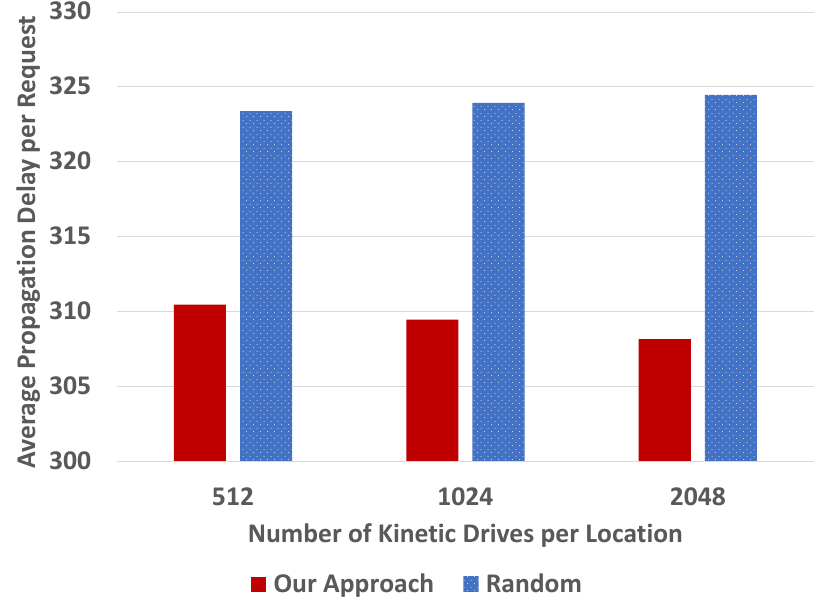
Figure 9. Average propagation delay per request (normalized): 32 regions, 1000